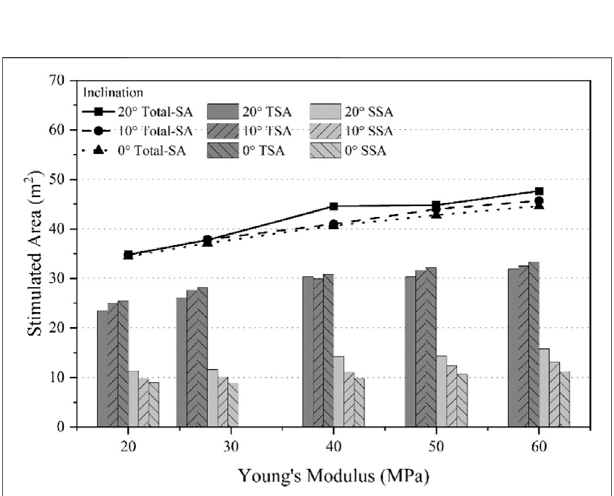
FIGURE 4 | Effect of caprock Young ’ s modulus and inclination on tension and shear stimulated areas (TSA and SSA).